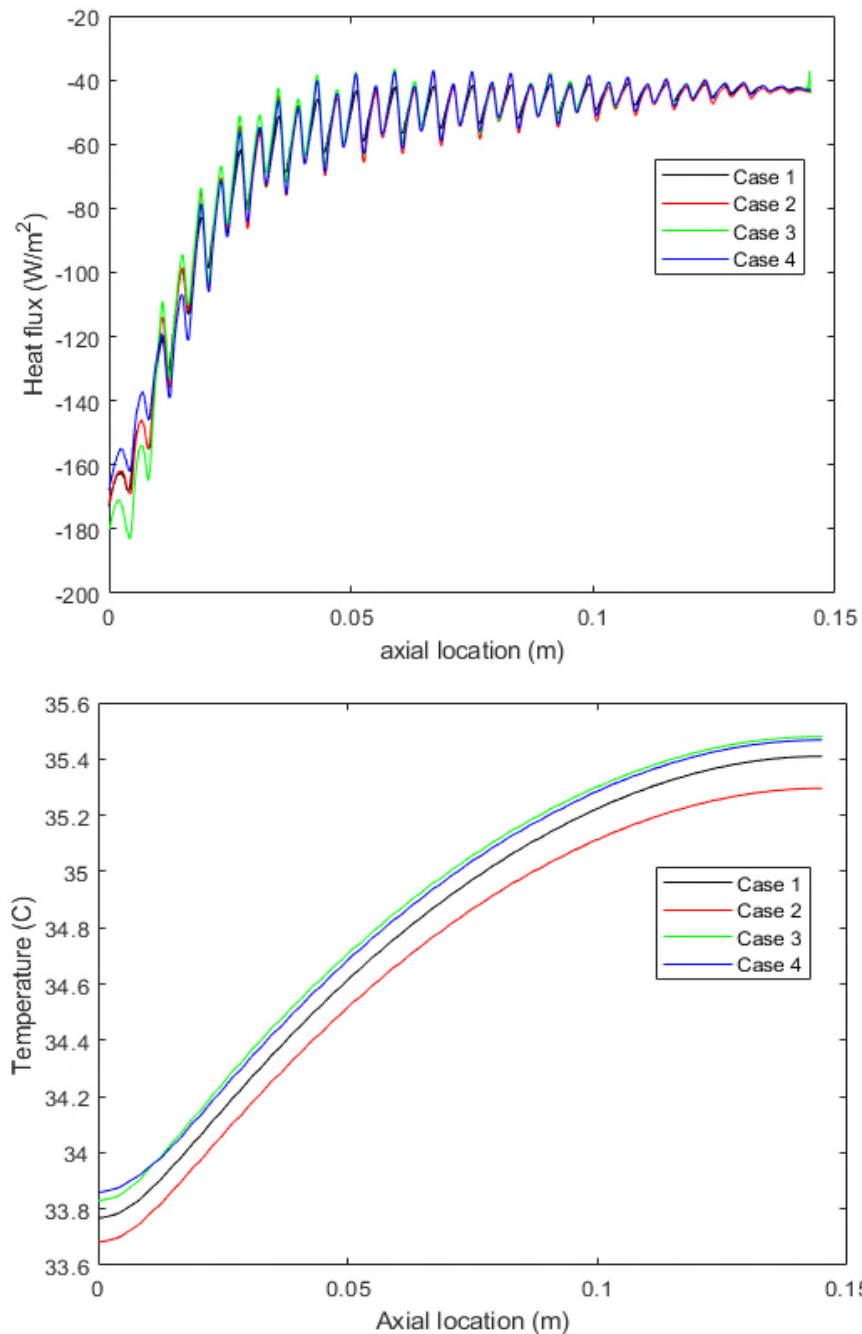
Figure 7. Variation of heat flux and surface temperature across the heat sink surface width for different cases at 0.412m/s, 27ºC, and t =